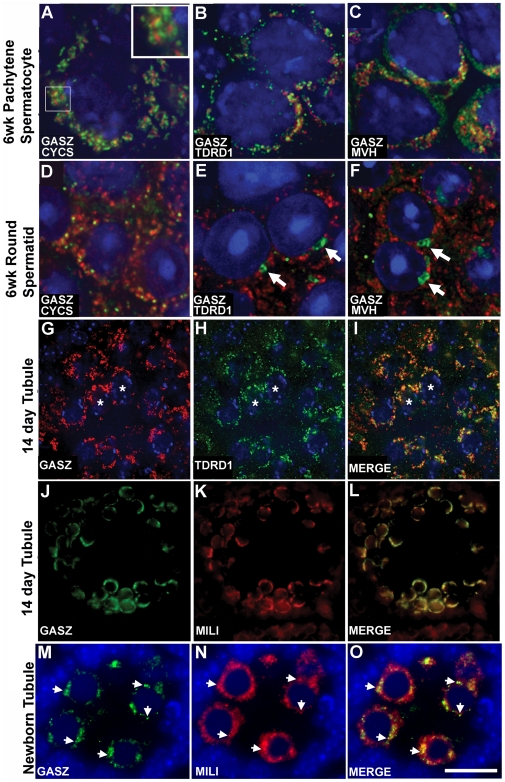
GASZ co-immunolocalization with intermitochondrial cement markers.(A–F) Immunofluorescent analysis of spermatocytes (A–C) and spermatids (D–F). (A,D) GASZ (red) localizes between mitochondrial clusters in spermatocytes using antibodies to cytochrome c (green). (A inset) Higher magnification. (B,E) Staining is shown for GASZ (red), TDRD1 (green). (C,F) Staining for GASZ (red) and MVH (green). Arrows in (E,F) identify the chromatoid body. Note the presence of the GASZ (red) foci and corresponding TDRD1 and MVH (green) foci in spermatocytes (A–C) but not in spermatids (D–F). (G–I) Staining is shown for GASZ (G), TDRD1 (H), and merged (I). (J–L) Staining is shown for GASZ (J), MILI (K), and merged (L). (M–O) Staining of newborn testes is shown for GASZ (M), MILI (N), and merged (O). Note the presence of the GASZ (green) foci and corresponding MILI (red) foci in gonocytes (arrowheads). [Scaling: 10,000×(A–F), 40X(G–L), and 400×(M–O) magnification.]